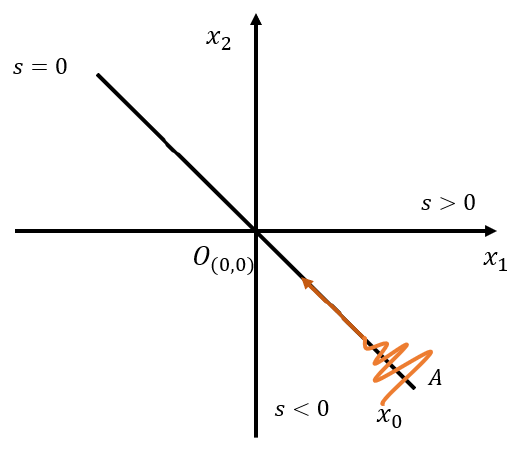
Figure 1. The s chematic diagram of sliding mode control. Figure 1. The schematic diagram of sliding mode